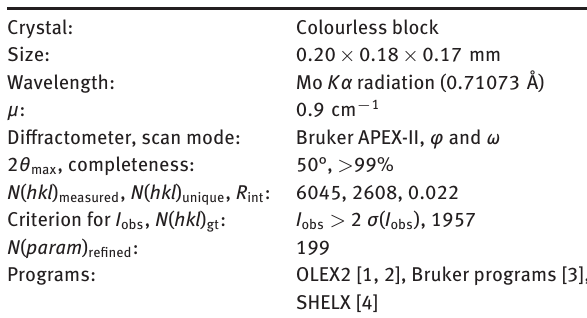
Table 1: Data collection and handling.